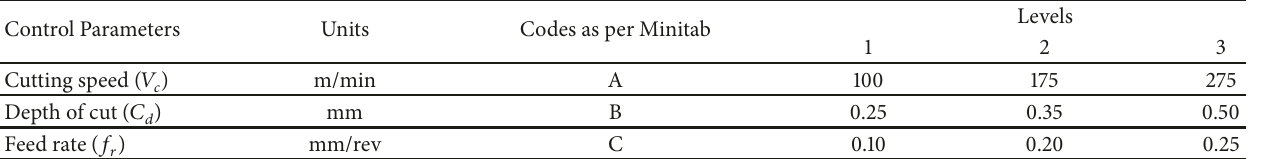
Table 3: Selected levels for the factors.